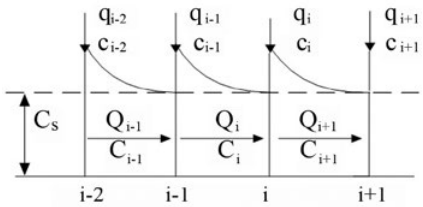
Fig. 4: Schema (cid:415) c diagram of segment-end-control approach for environmental capacity estimation Fig. 4: Schematic diagram of segment-end-control approach for environmental capacity